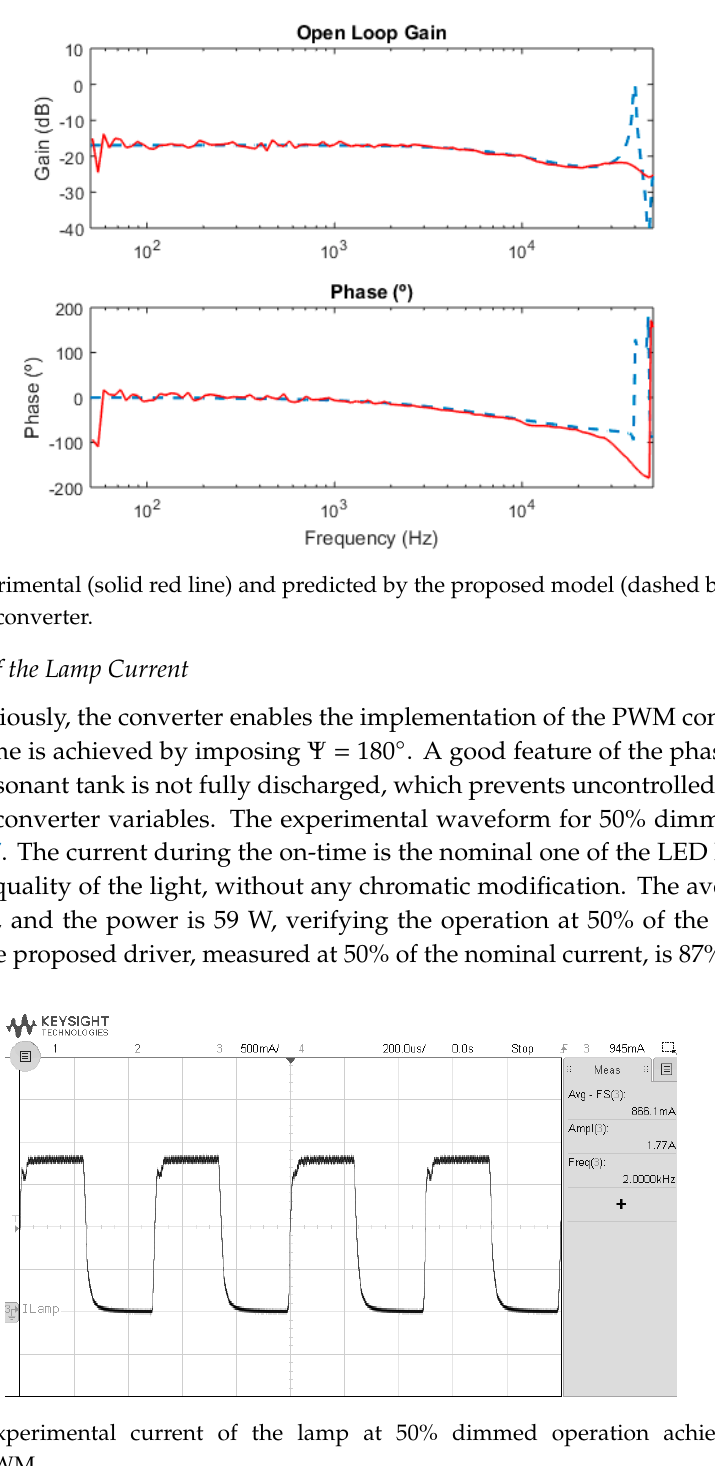
Figure 16. Experimental (solid red line) and predicted by the proposed model (dashed blue line) AC response of the converter.